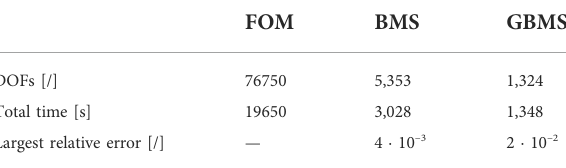
TABLE 2 Overview of the results: DOFs after applying the Bloch- Floquet BCs, the total required time and the relative error when applying the BMS and GBMS technique to the vibro-acoustic 3D periodic